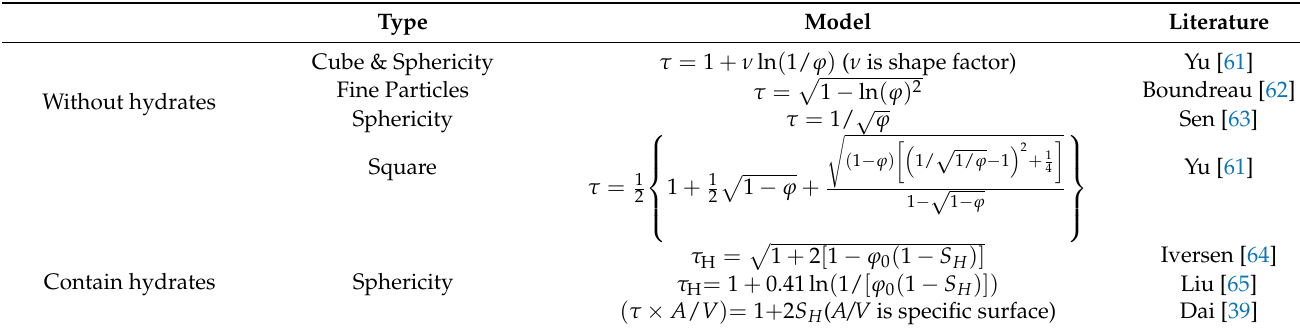
Table 1. Tortuosity models of sediments without/with